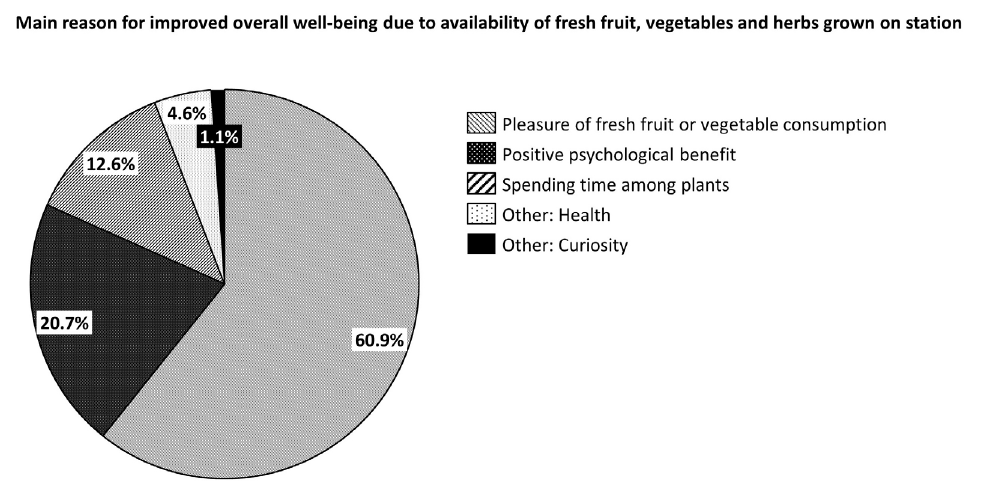
Figure 2: Respondents that indicated that the availability of fresh fruit, vegetables and herbs grown on the Neumayer Station (85%, 88 individuals) would improve their overall well-being were asked to indicate the main reason for this expected improvement. They could either choose one of the given three options or give other answers.